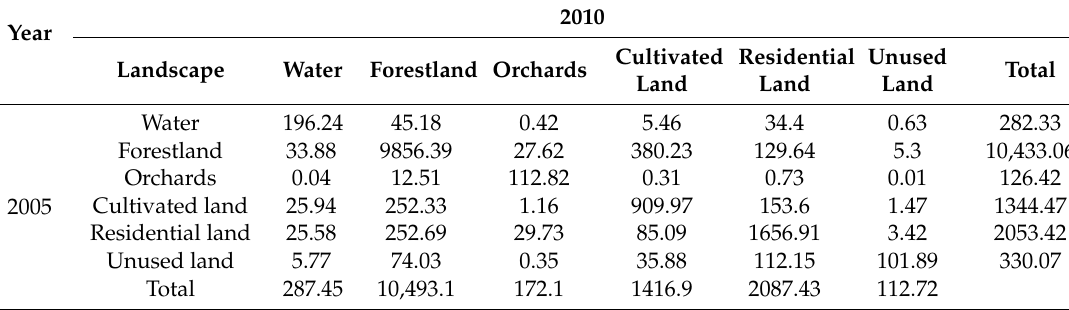
Table 21. The landscape transition matrix from 2005 to 2010 (km 2 ).